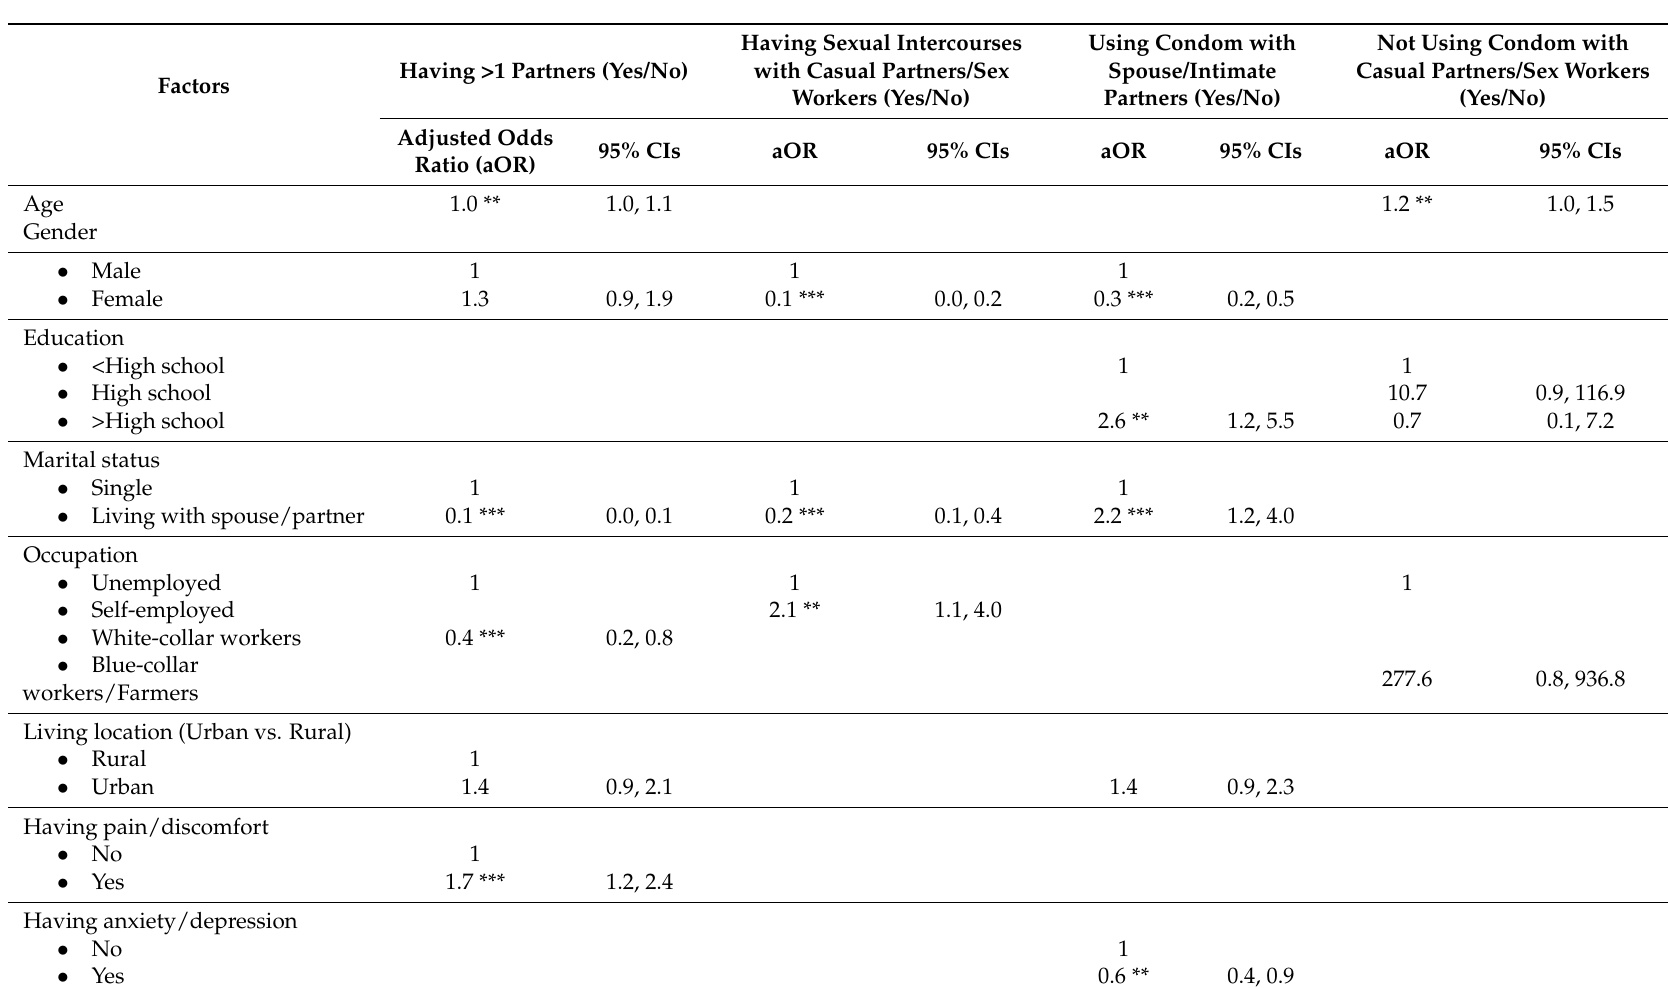
Table 4. Factors associated with number of sexual partners and condom